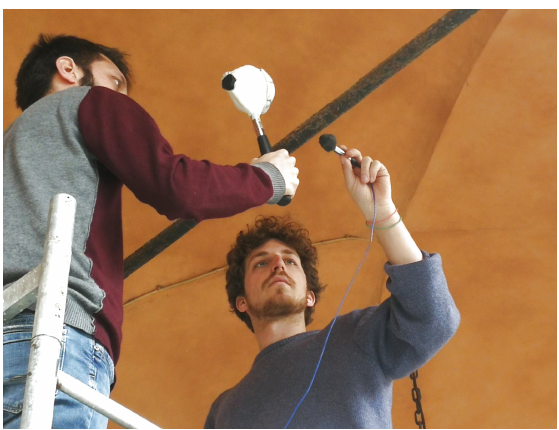
Figure 6. In-situ acoustic testing: measurements with a professional microphone in the Palazzo Arcivescovile of